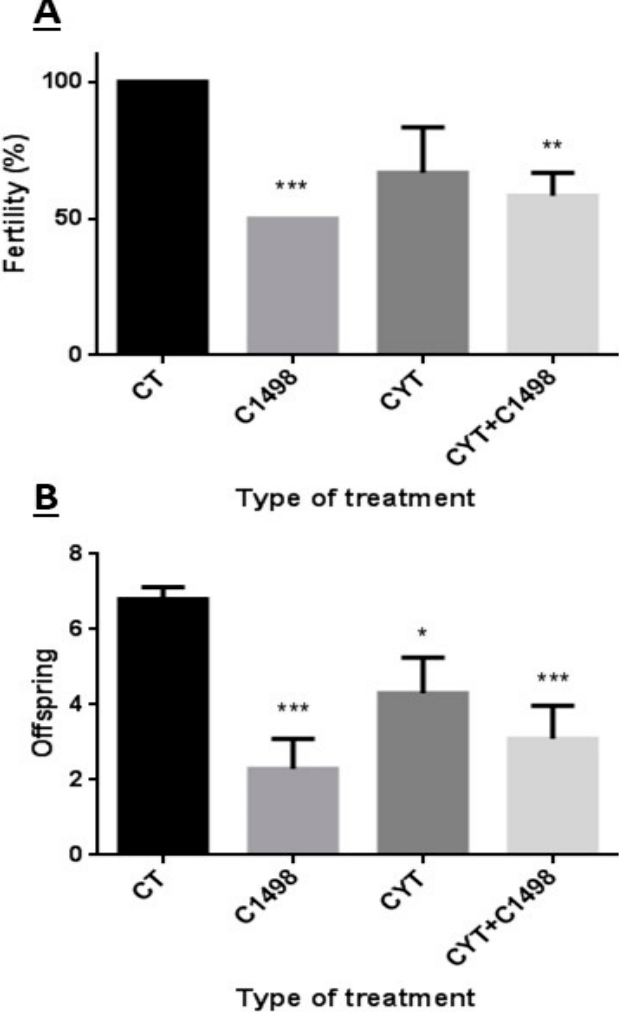
Figure 6. Effect of AML cells, cytarabine, and the combination of both on mice fertility and number of offspring: Mice were treated as described in Figure 1. Two weeks post-treatment, a single male from each group was mated with two females. After two weeks, the females were separated each to a single cage. The number of pregnant females ( A ) and number of offspring from each female were counted after five weeks ( B ). The results are representative of three independent experiments with four mice in each group. * Significant compared to control. * p < 0.05; ** p < 0.01; *** p < 0.001.